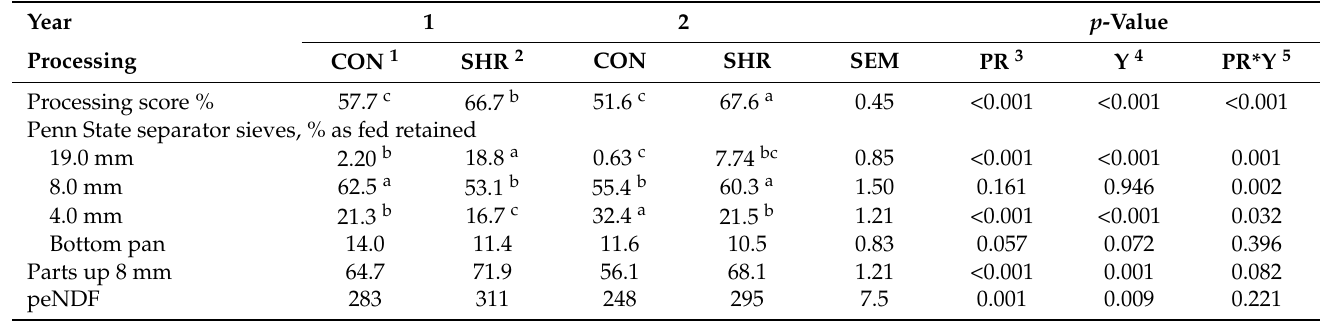
Table 2. The effect of processing on the quality of kernel processing and particle size.